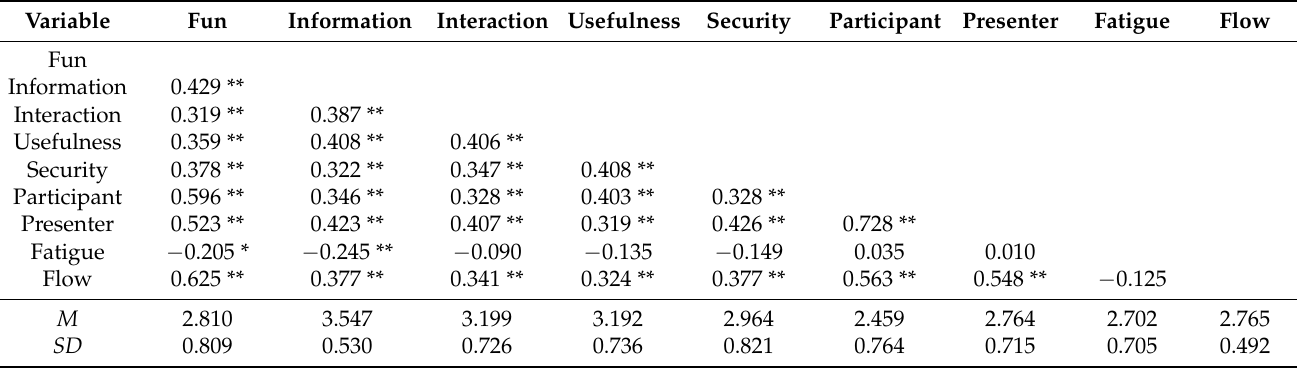
Table 7. Correlation coefficients between latent